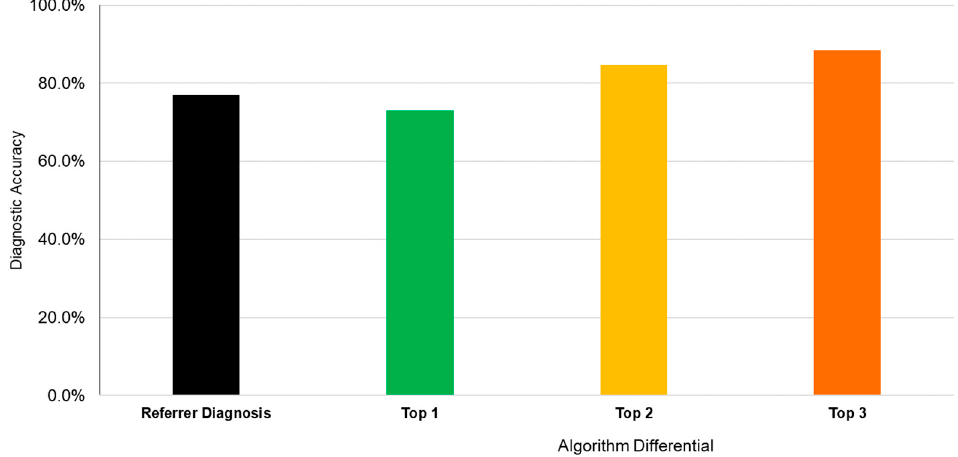
Figure 4. Referrer and algorithm diagnostic accuracy for urgent conditions.